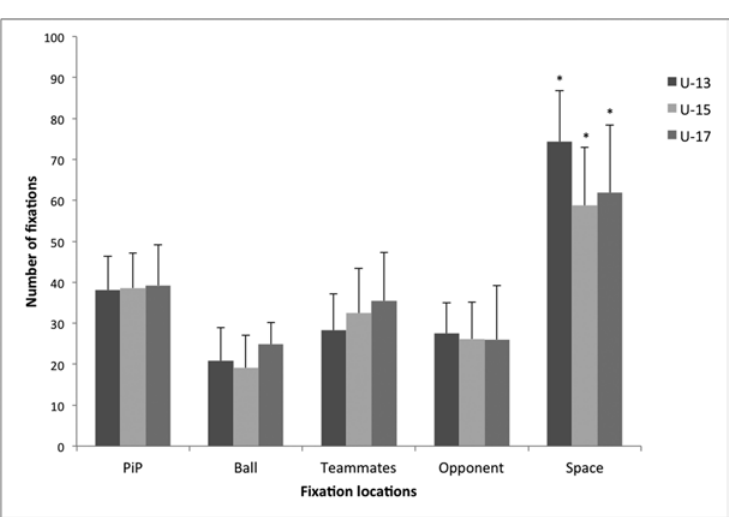
Figure 2. Means and standard deviation for the time of fixations made by each group in pre-defined locations in the video sequences